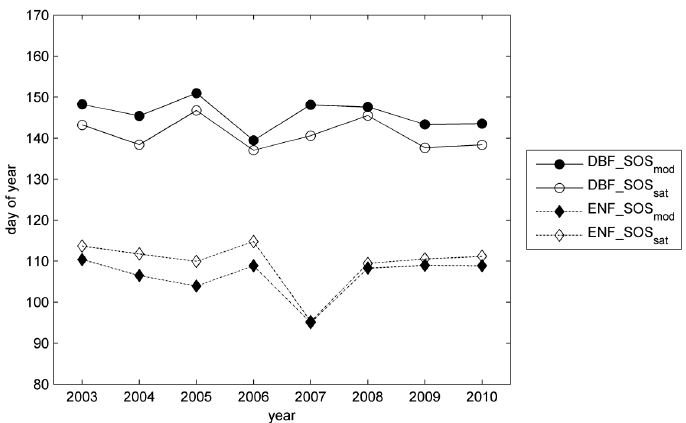
Figure 10. Interannual variations of the start of season in evergreen coniferous forest and deciduous broad-leaf forest in Finland derived from the JSBACH model and from remote sensing observations.